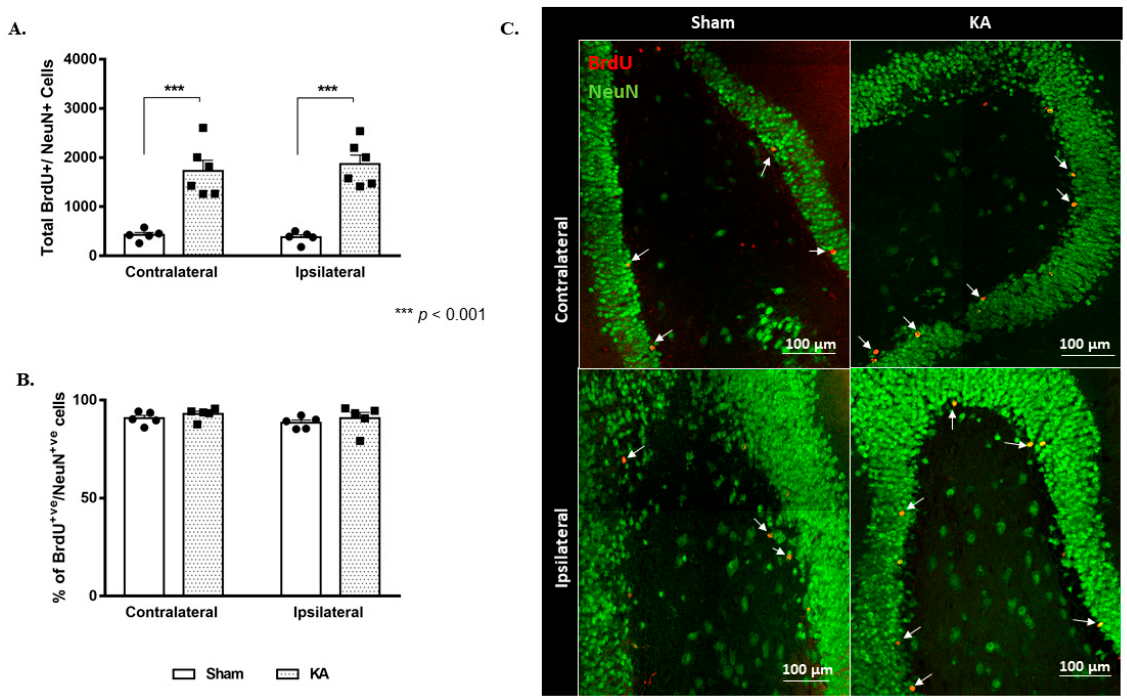
Figure 4. Sustained increase in neurogenesis in the ipsilateral and contralateral dentate gyrus following continuous micro-perfusion with kainic acid into the AN. ( A ) Stereological quantification of BrdU-labeled cells in the DG of the sham ( n = 5) and KA micro-perfused ( n = 6) groups at week 4. Determination of statistical significance of differences was made using two-way ANOVA followed by Sidak’s multiple comparison test. ( B ) Graph showing the percentage of double-positive BrdU/NeuN out of the total BrdU-positive cells in the contralateral and ipsilateral DG of the sham and KA micro-perfused rats. ( C ) Representative confocal images showing immunofluorescence labeling of NeuN and BrdU in the DG of the sham and KA micro-perfused groups at week 4. BrdU-positive cells (arrows) in the KA micro-perfused group in the ipsilateral and contralateral DG at the site of injection. Images were taken as Z stacks using a 40X-oil objective. +ve: positive. The highest increase was in the caudal region of the DG in both the ipsilateral and contralateral sides: from 198 ± 23 in the contralateral side of the sham group to 1198 ± 216 after KA micro-perfusion ( p = 0.0025, Figure 5A,B), and from 171 ± 17 in the ipsilateral side of the sham group to 1246 ± 186 after KA micro-perfusion ( p = 0.0006, Figure 5A,B).